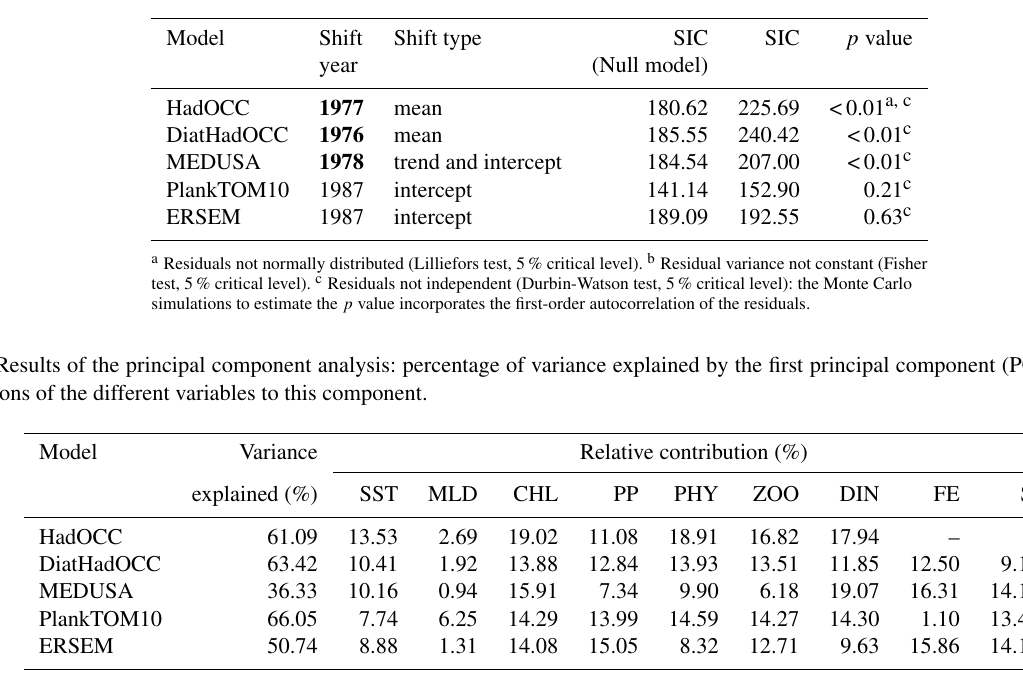
Table 3. Results from change-point detection analysis on the first principal component (PC1) of each model. Years in bold have a significant shift ( p value <0.05).